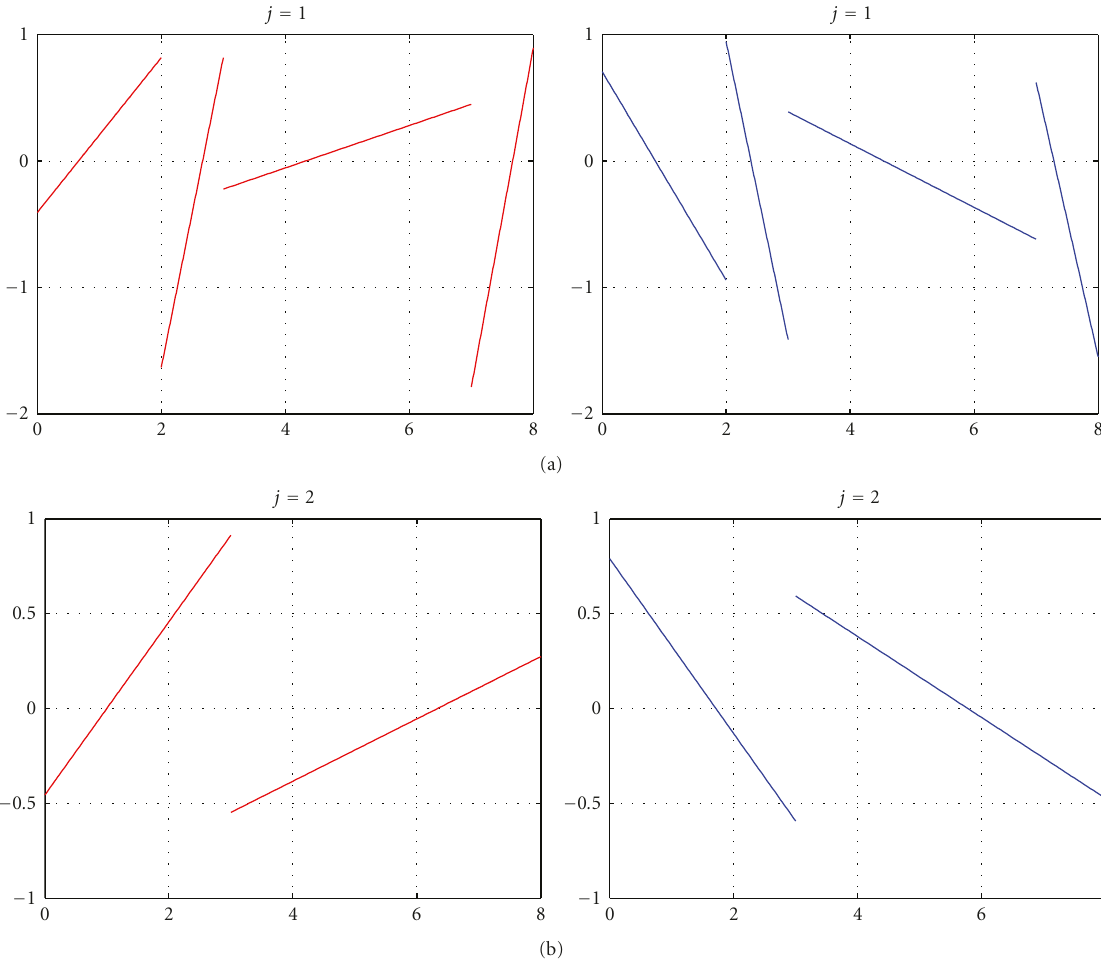
Figure 3: Orthonormal linear spline wavelet basis at resolution levels j = 1,2.